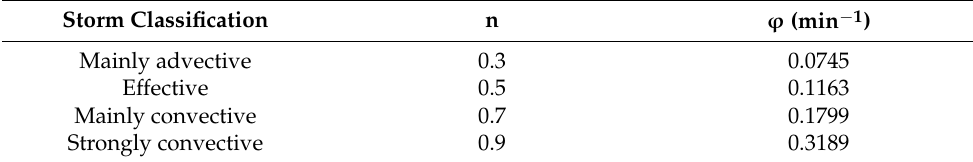
Table 6. Shape parameter, ϕ , assigned for each n-index value selected. Storm Classification n ϕ (min − 1 ) Mainly advective 0.3 0.0745 Effective 0.5 0.1163 Mainly convective 0.7 0.1799 Strongly convective 0.9 0.3189